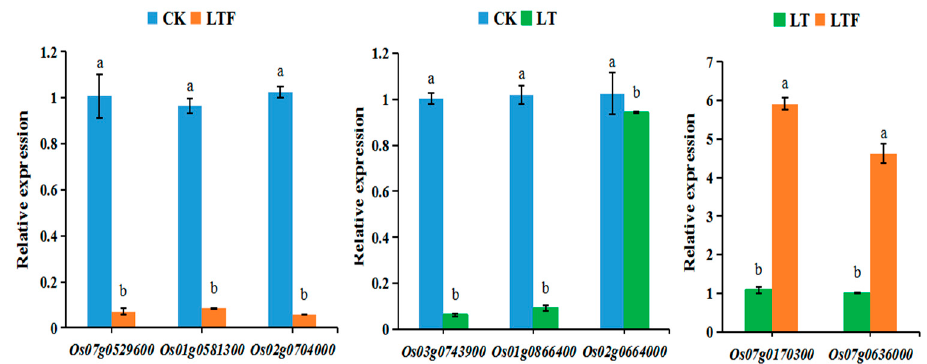
Figure 5. Comparison of genes expression levels using RNA-Seq and qRT-PCR. LT, low temperature treatment for 3 d; LTF, low temperature flooding treatment for 3 d; CK, control. Data represent the mean ± SE ( n = 3), and different lowercase letters indicated significant differences at p < 0.05.